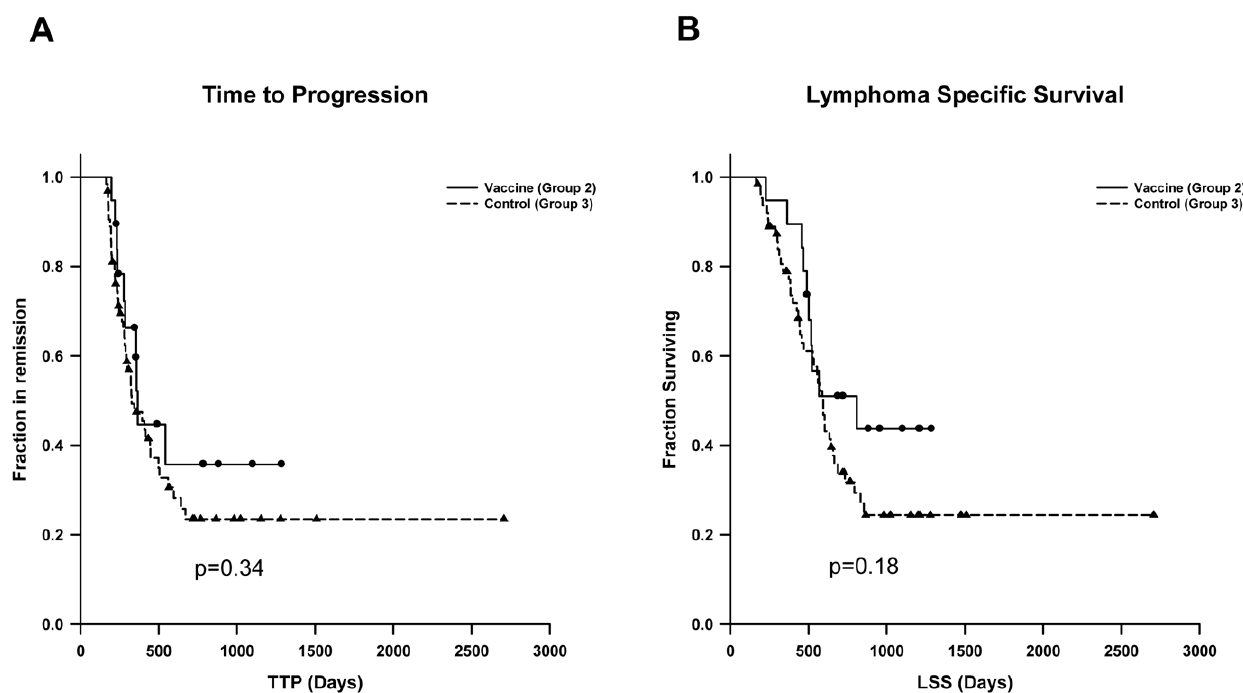
Figure 2. Kaplan Meier estimates comparing vaccinated Group 2 to unvaccinated control Group 3 for (A) TTP (p=0.34) and (B) LSS (p=0.18).